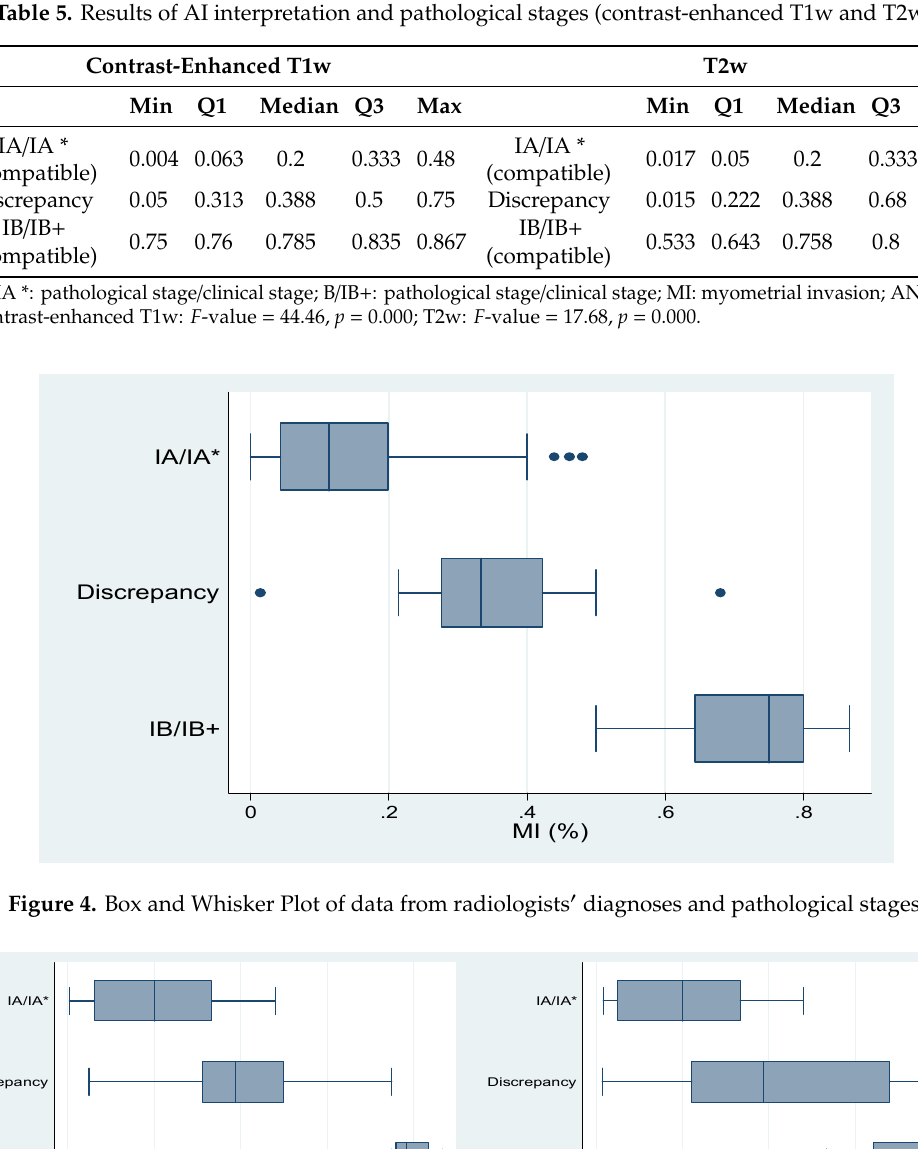
Table 5. Results of AI interpretation and pathological stages (contrast-enhanced T1w and T2w).